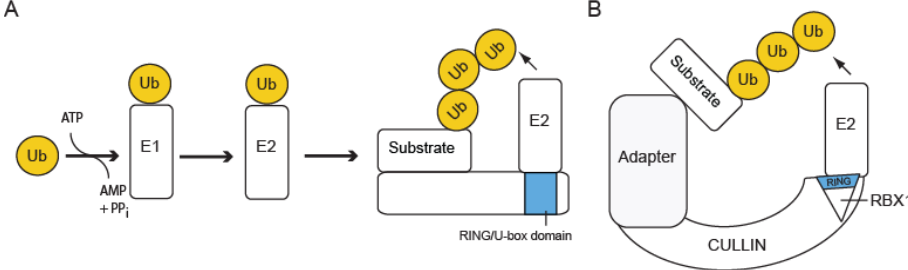
Figure 1. The Ub conjugation pathway. ( A ) Ubiquitin (Ub) is first activated and bound by E1 in an ATP-dependent reaction, after which it is transferred to E2. Then, E3 interacts simultaneously with the substrate and the E2-Ub conjugate, facilitating transfer of Ub to the substrate. E3 depicted in (A) is a single subunit which interacts via its RING or U-box domain with E2. An example of a RING-type E3 in JA signaling is DAD1-ACTIVATING FACTOR (DAF) [17]. The HECT-type E3s are not shown. ( B ) E3 can also occur as a multi-subunit E3 consisting of a CULLIN protein serving as scaffold for an adaptor module that binds the substrate, and the RING domain-containing RBX1 protein that binds E2. An example of a CULLIN-RING ubiquitin ligase (CRL) in JA signaling is SCF COI1 .